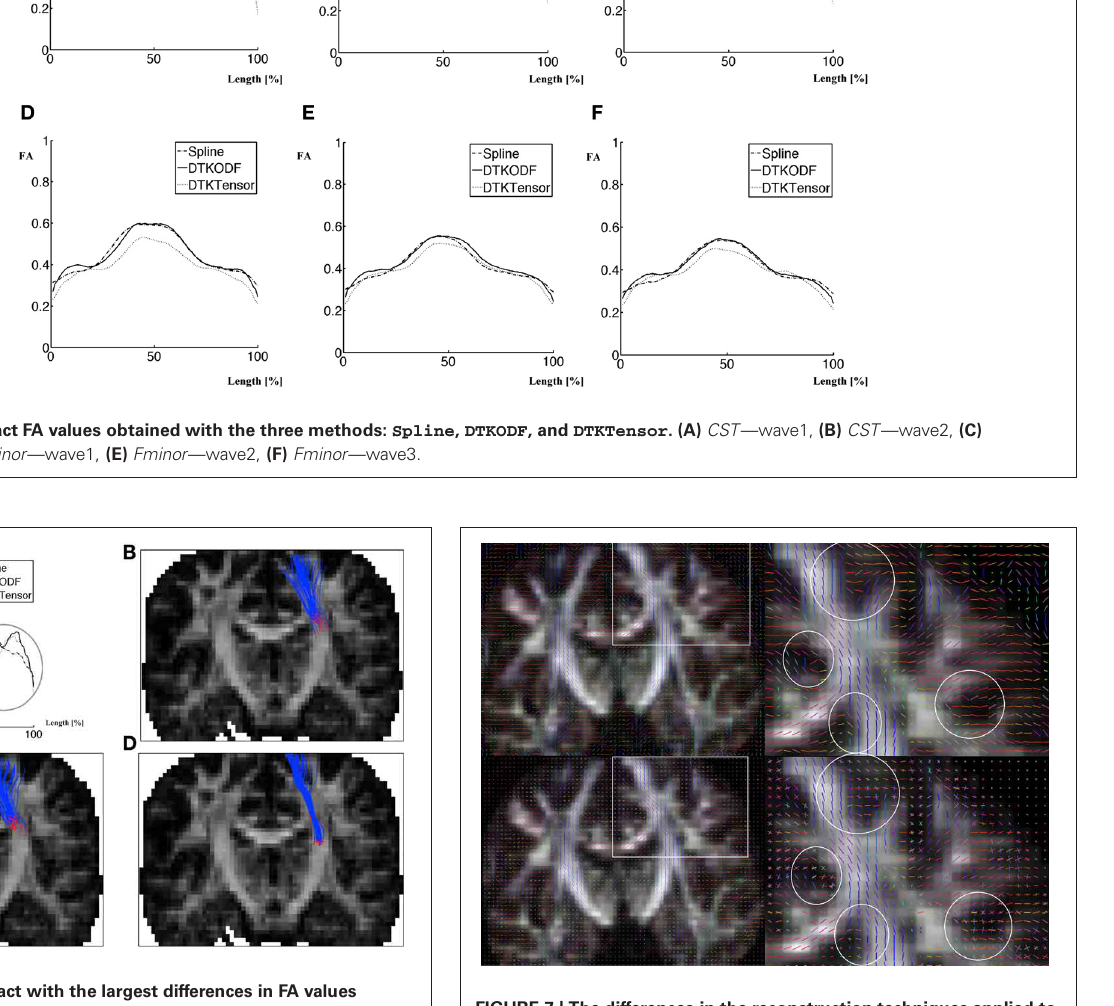
FIGURE 7 | The differences in the reconstruction techniques applied to one of our datasets, showing the principal eigenvectors of the diffusion tensors (top), and the dODF local maxima (bottom). Details of the rectangular inserts are shown to the right. Along the CST , there are a few neighboring voxels where the dODF reveals more than one fiber direction. These are indicated by white circles and show that the voxel-wise dODF provides additional information about fiber directions, compared to the diffusion tensor